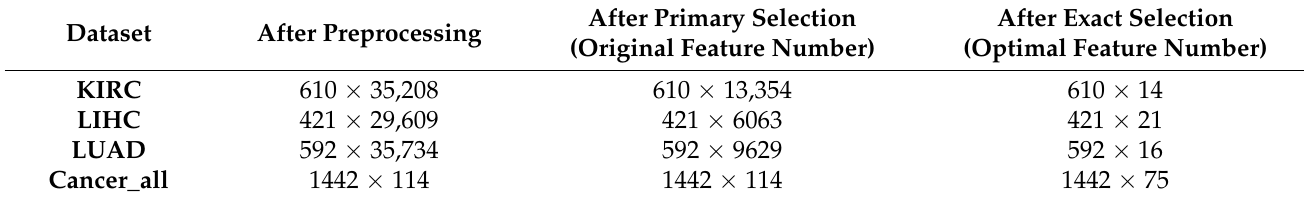
Table 2. Feature Dimension of Datasets.